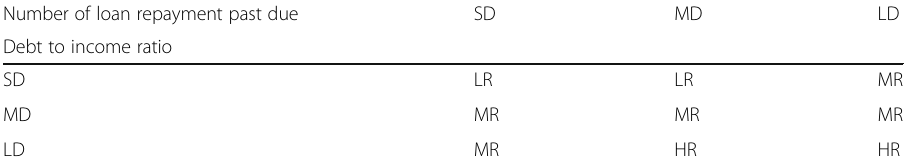
Table 3 Fuzzy evaluation for debt to Income ratio and Number of Loan Repayments Past Due. This table combines two input variables. It describes that if the number of loan repayments past due is low (SD) and the amount of debt to income is low (SD) then the customer is recognized as low-risk. If the number of loan repayments past due is at around the middle (MD) and the amount of debt to income is high (LD) then the customer is recognized as the high-risk (HR). To limit the describing of the value of factors, we have used SD as little, MD as medium and LD as